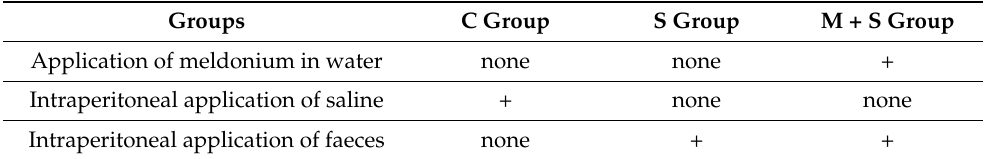
Table 4. The study designs. C—control (sham) group of animals (free access to tap water for four weeks, and then received a saline injection); S—septic group of animals (free access to tap water for four weeks, and then received a faecal intraperitoneal injection); and M + S—meldonium-septic group of animals (free access to tap water with meldonium for four weeks, and then received a faecal intraperitoneal injection). The number of animals per group = 8. Groups C Group S Group M + S Group Application of meldonium in water none none + Intraperitoneal application of saline + none none Intraperitoneal application of